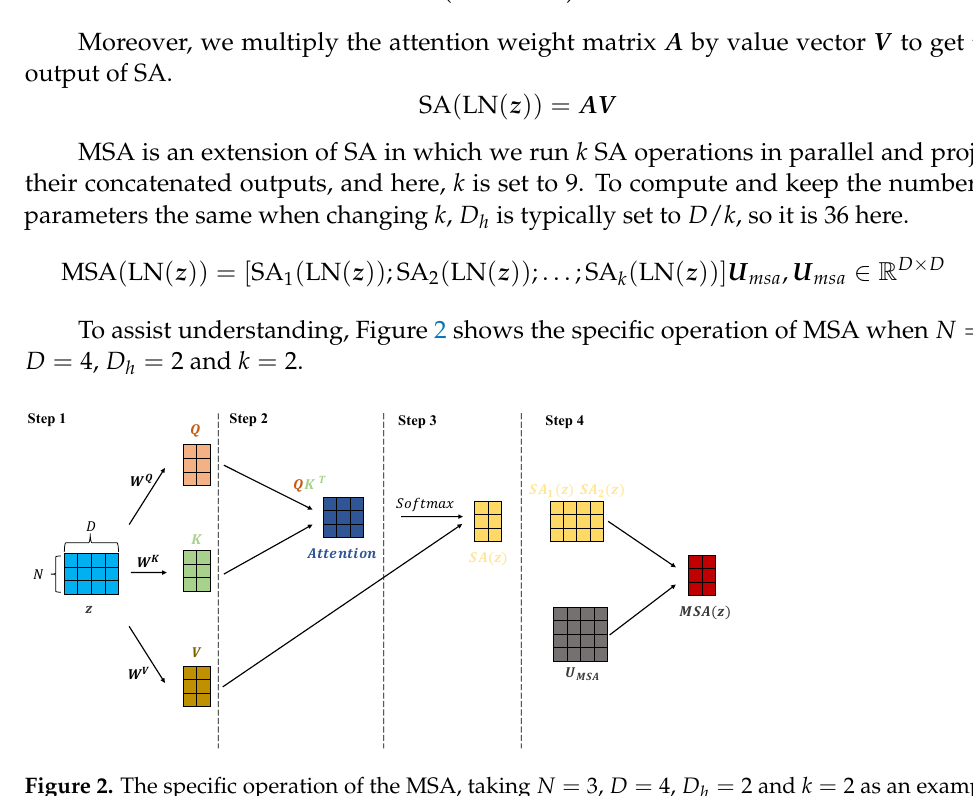
Figure 2. The specific operation of the MSA, taking N = 3, D = 4, D h = 2 and k = 2 as an